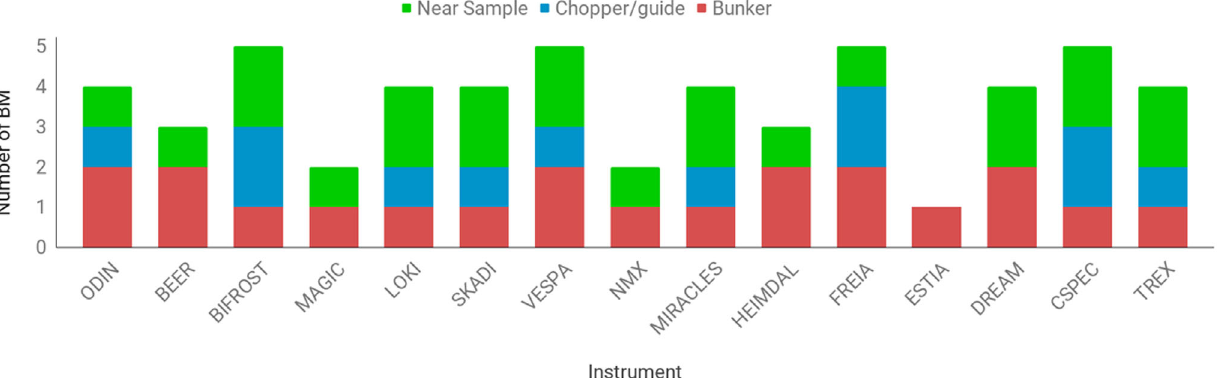
FIG. 1. The number of beam monitors anticipated to be required by the ESS instruments as of January 2020. The beam monitors are categorised into those near (before or after) the sample, along the neutron guides or next to choppers, or close to the beam extraction from the moderator in the “ bunker ” region.